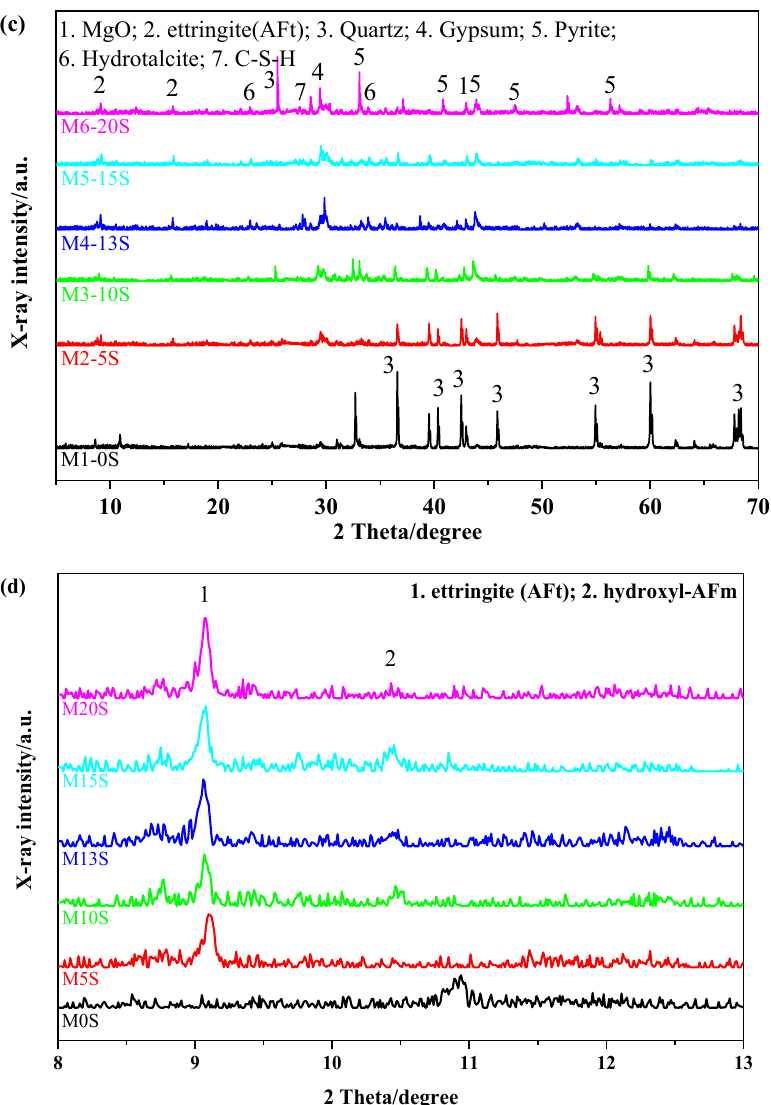
Figure 2. XRD patterns of MASMs with and without SRCT composite using both coarse and fine scanning modes: ( a , b ) 7d; ( c , d ) scanning modes: ( a , b ) 7d; ( c , d ) 28d.